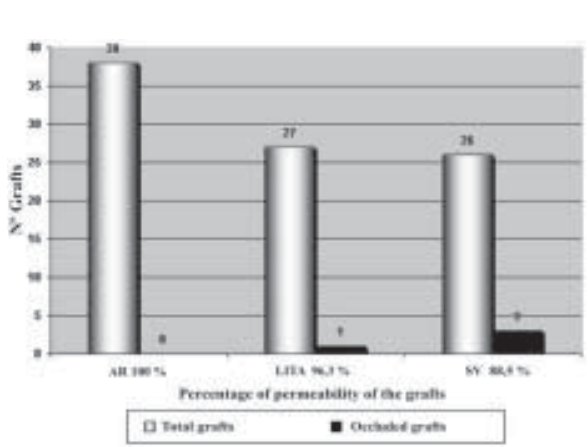
Fig. 1 – Result of the patency of the grafts in the early restudy